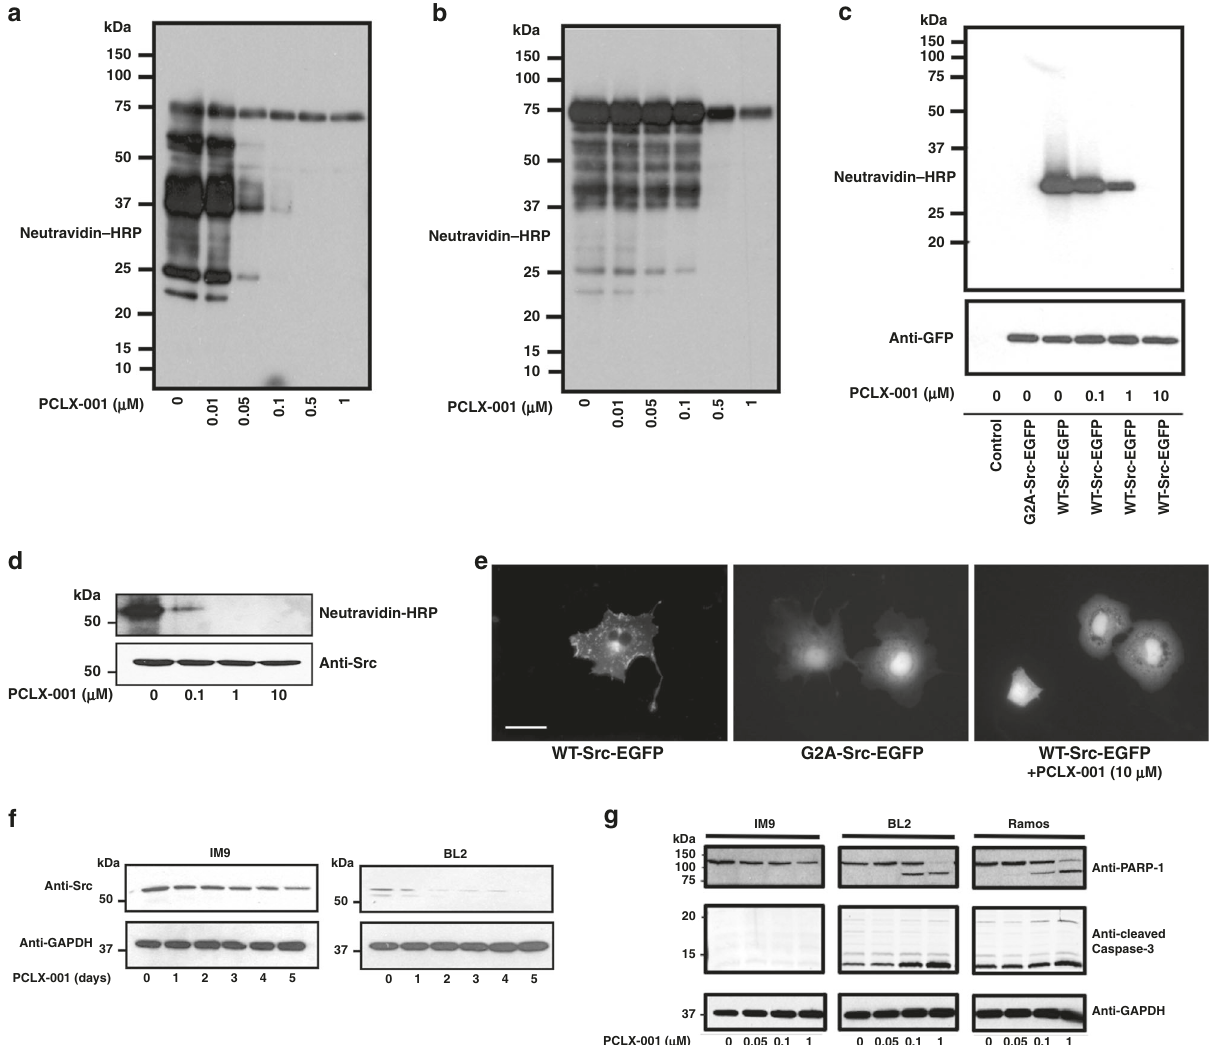
Fig. 2 PCLX-001 selectively inhibits myristoylation in vitro and induces apoptosis in lymphoma cell lines. Click chemistry was used on alkyne-myristate labeled cell lysates to determine overall protein myristoylation levels in: BL2 cells ( a ) and IM9 cells ( b ) treated for 1 h with 0.01 – 1.0 µ M PCLX-001, myristoylation levels of a WT-Src-EGFP construct expressed in COS-7 cells ( c ) and, myristoylation of immunoprecipitated endogenous pp60-Src in IM9 cells following 1 h treatment with 1.0 – 10 µ M of PCLX-001 ( d ). Fluorescence micrographs of COS-7 cells transfected with a WT-Src-EGFP (left), non- myristoylatable G2A-Src-EGFP mutant (center), and a WT-Src-EGFP construct treated with 10 μ M PCLX-001 for 24 h (right) ( e ). Scale bars are equal to 10 μ m. Endogenous Src protein levels in IM9 and BL2 cells treated with 1 μ M PCLX-001 for 0 – 5 days measured by Western blotting ( f ). Western blotting of cleaved PARP-1 and cleaved caspase-3 in IM9, BL2, and Ramos cell lysates following 72 h incubation with 0 – 1.0 µ M PCLX-001 (composite gels) ( g ). All data shown are representative of at least three independent experiments. GAPDH serves as loading control. Source data are provided as a Source Data fi